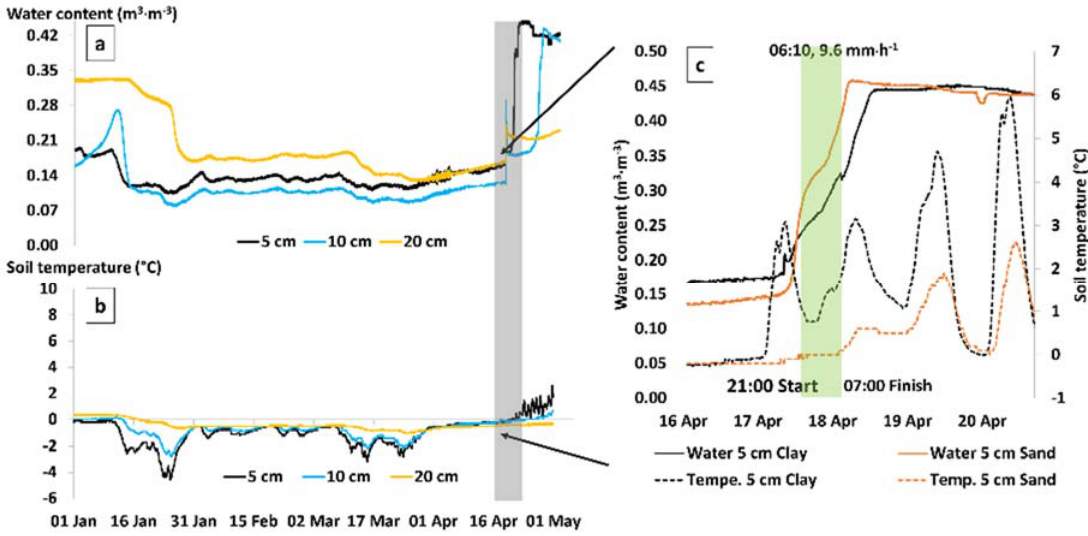
Figure 3. Measured soil water content ( a ) and soil temperature ( b ) in the clay during winter 2013 with the insert diagram ( c ) showing measured soil water content and soil temperature at 5 cm depth in the clay and sand during the rain event of interest in 2013 (duration marked with grey band in ( a , b )). The period with the highest precipitation intensities is marked with a green band in ( c ).